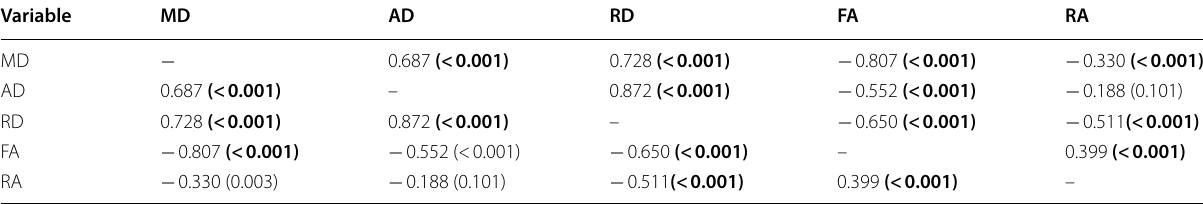
Bold values represent significant P values Data are Spearman’s correlation coefficient P value